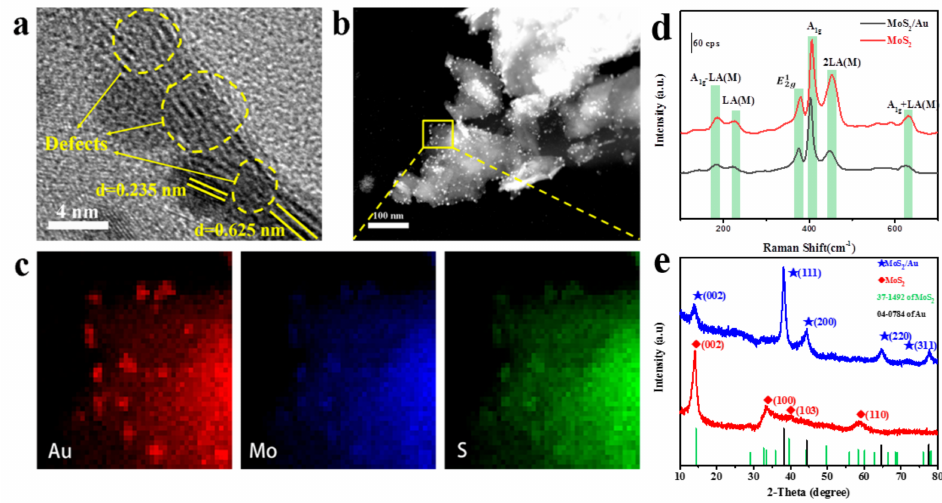
Figure 1. High resolution TEM image of MoS 2 /Au heterojunctions ( a ); HAADF-STEM image of MoS 2 /Au heterojunctions ( b ) and corresponding STEM-EDS element maps of Au, Mo, and S ( c ); Raman spectra ( d ); and XRD patterns ( e ) of MoS 2 and MoS 2 /Au